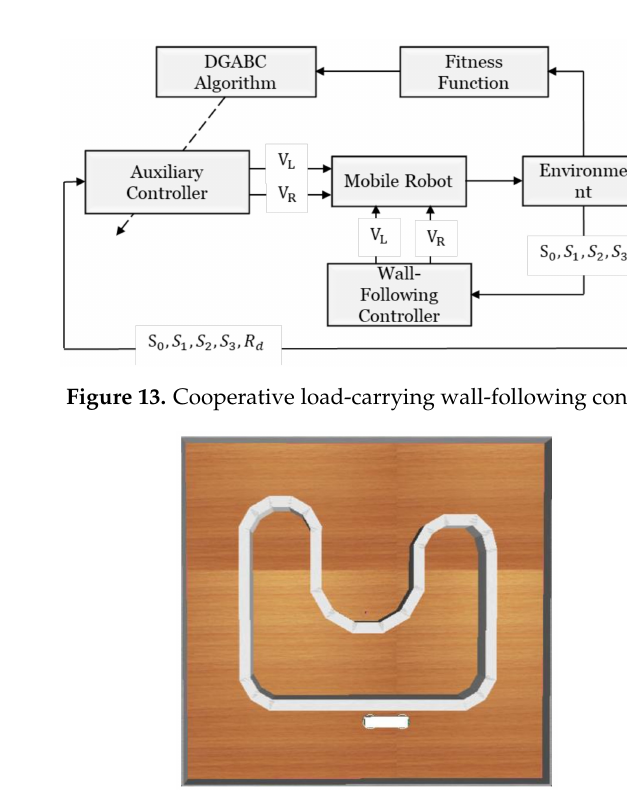
Figure 14. Training environment for cooperative load-carrying wall-following